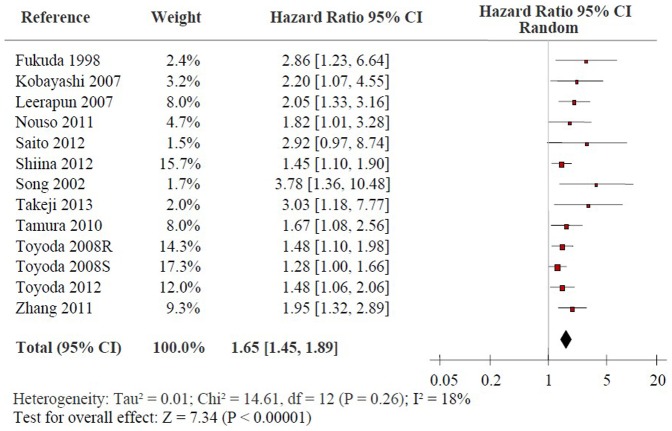
Forrest plot of the association between high pre-treatment serum AFP-L3% and OS of HCC patients.Hazard ratio and associated 95% confidence interval were calculated. OS: overall survival; AFP-L3: the lens culinaris agglutinin-reactive fraction of α-fetoprotein; HCC: hepatocellular carcinoma.